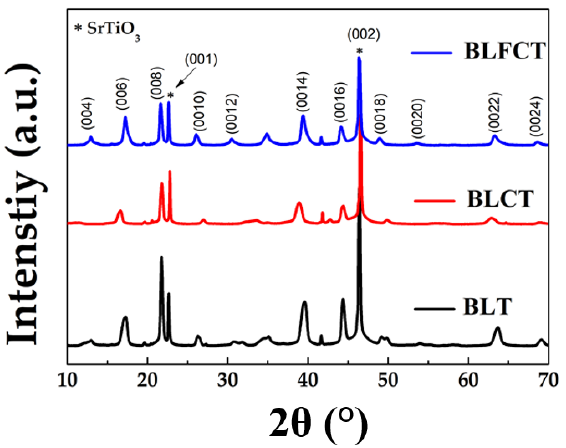
Figure 2. X-ray diffraction patterns of the BLT, BLCT, and BLFCT epitaxial films on the Nb-doped SrTiO 3 (001) substrate.